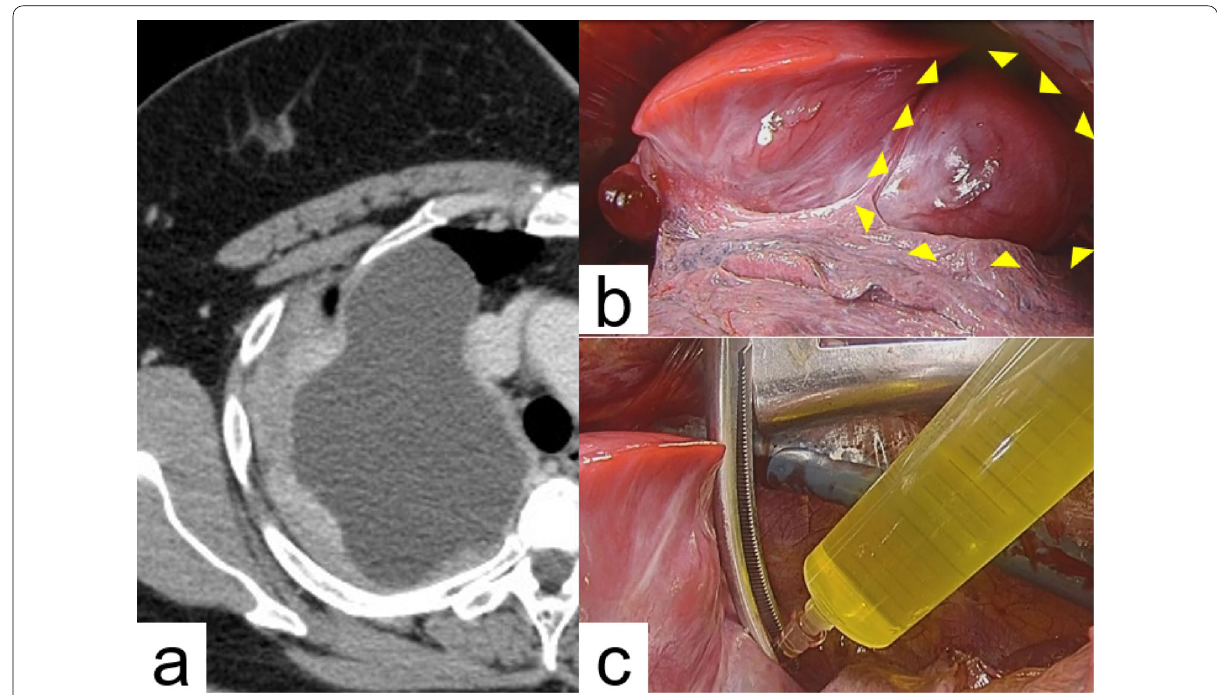
Fig. 2 Preoperative computed tomography and intraoperative findings of rapid enlarged tumor in the right upper lobe. a The right upper lung lesion, especially cystic component, increased in size to 120 mm over a 7-month period. b The cystic component of the tumor, which had a dark-red surface, occupied most right upper lobe volume (yellow arrowheads). c Approximately 330 ml of serous fluid was egested from the